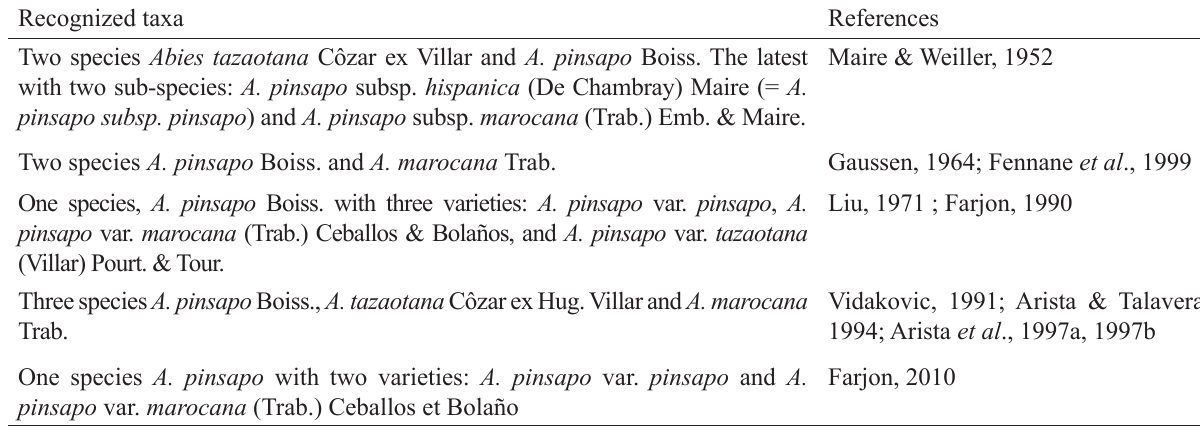
Table 1. Classifications proposed for Moroccan and Spanish fir populations.